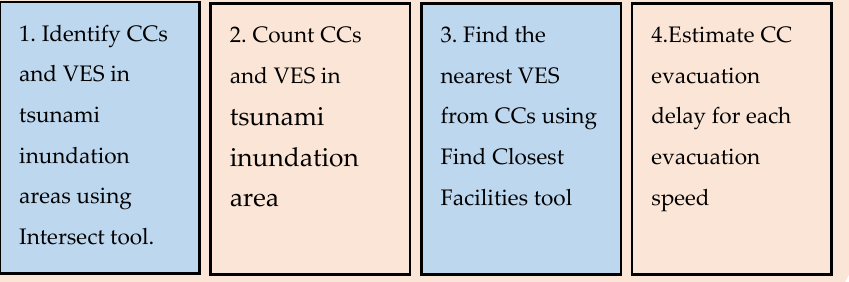
Figure 3. Analysis flow. Analysis using ArcGIS Pro tools is shown in blue. CCs, childcare centers; VES, vertical evacuation shelters.